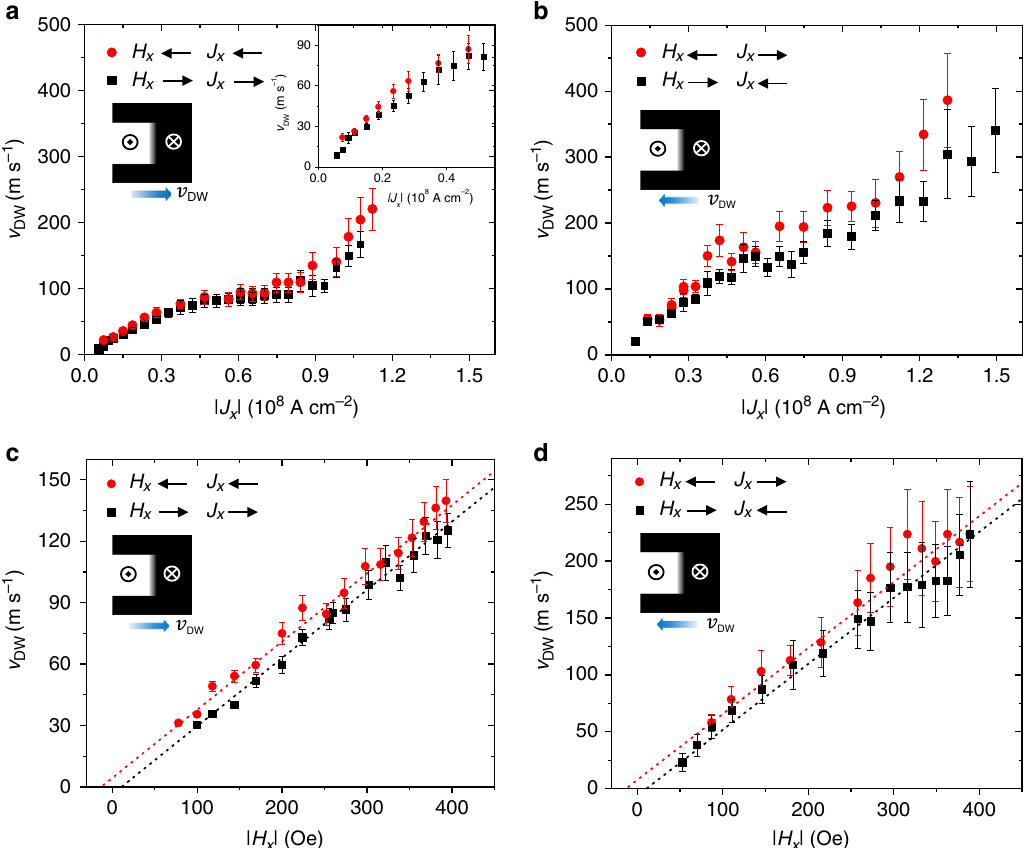
Fig. 4 DW velocity upon expansion and contraction of domains in TmIG/Pt surrounded by uniformly magnetized TmIG. a v DW of an up – down DW (corresponding to a + m domain in a – m medium) as a function of J x upon expansion and b contraction. The magnetic fi eld is set to | H x | = 300 Oe. The inset in a shows an enlarged view of v DW in the fl ow regime at low current density. c v DW of an up – down DW as a function of H x upon expansion and d contraction. The current density is fi xed at | J x | = 0.75 × 10 8 A cm − 2 in either case. DWs move faster when J x is opposite to v DW (red symbols), indicating the presence of a weak DMI favoring left-handed Néel chiral DWs. Dashed lines in either c or d are linear fi ts to the experimental data assuming the same slope of v DW ( H x ) for both polarities of J x and opposite magnetic fi eld at which v DW crosses zero, which allows evaluating the effective DMI fi eld | H DMI | ~ 12 ± 3 Oe (see ref. 15 ). The error bars account for the uncertainty in estimating v DW from each